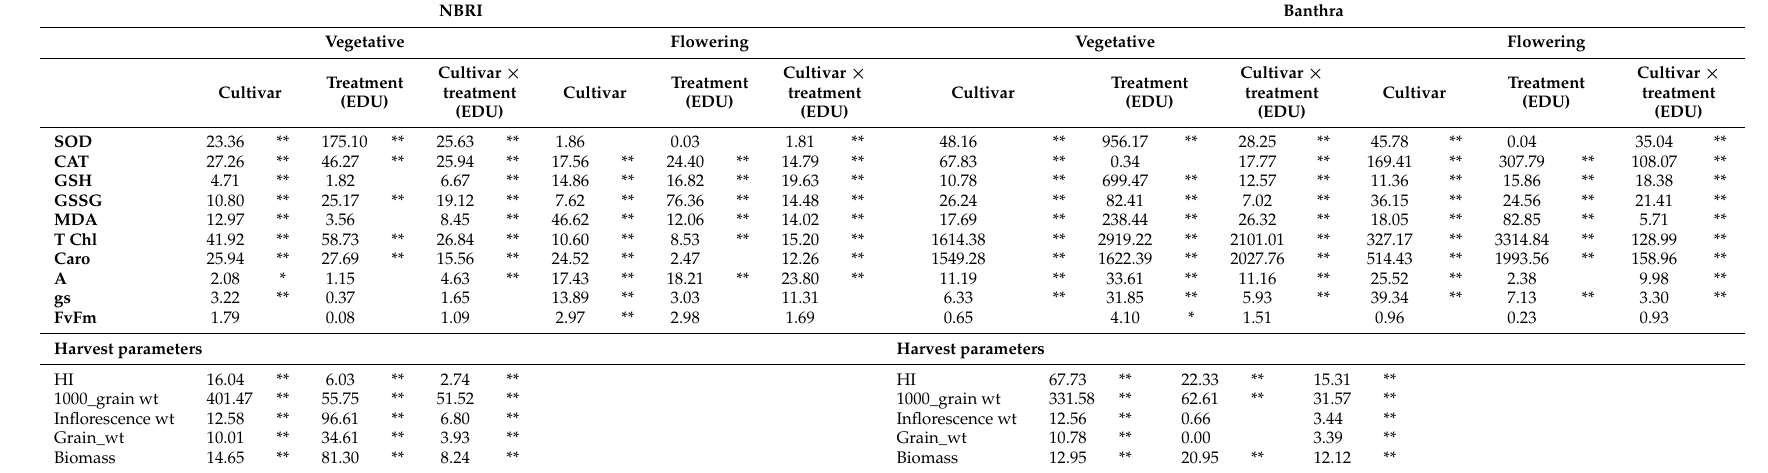
Table 1. F ratios and levels of significance of multivariate ANOVA test for different parameters of all the 11 tested cultivars. Significant results of two-way ANOVA are marked with asterisks (* p < 0.05 and ** p < 0.01) for Cultivar, Treatment (EDU) and Cultivar × treatment (EDU) at experimental sites; NBRI and Banthra at vegetative, flowering and harvest phase. Superoxide dismutase activity (SOD), catalase activity (CAT), reduced glutathione (GSH), oxidised glutathione